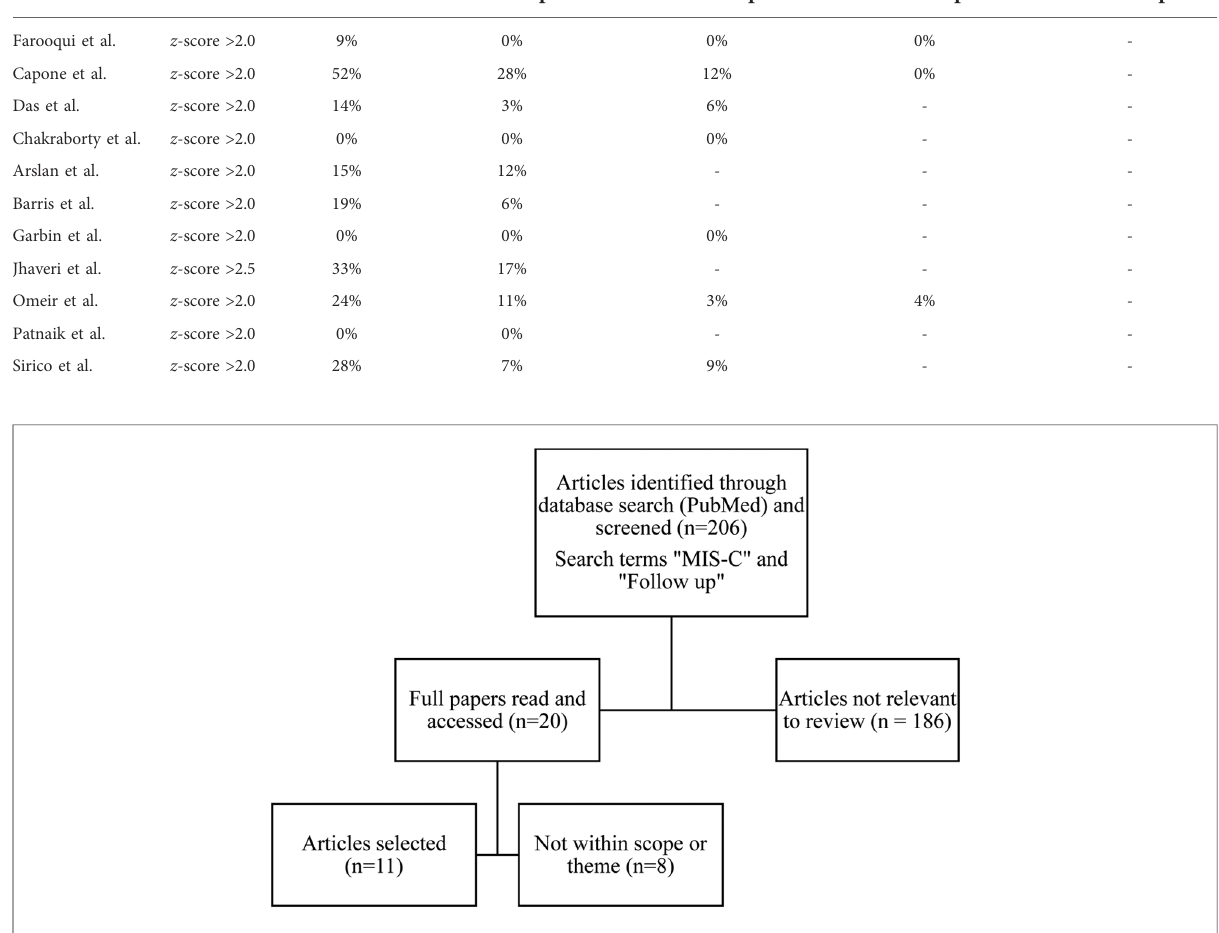
FIGURE 1 PubMed selection